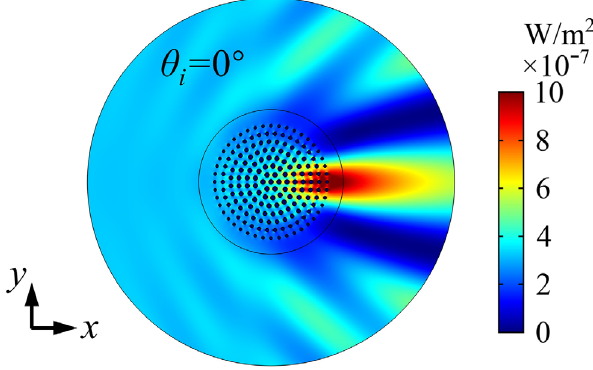
Figure 9. Wave intensity fi eld of the Luneburg lens with an annular